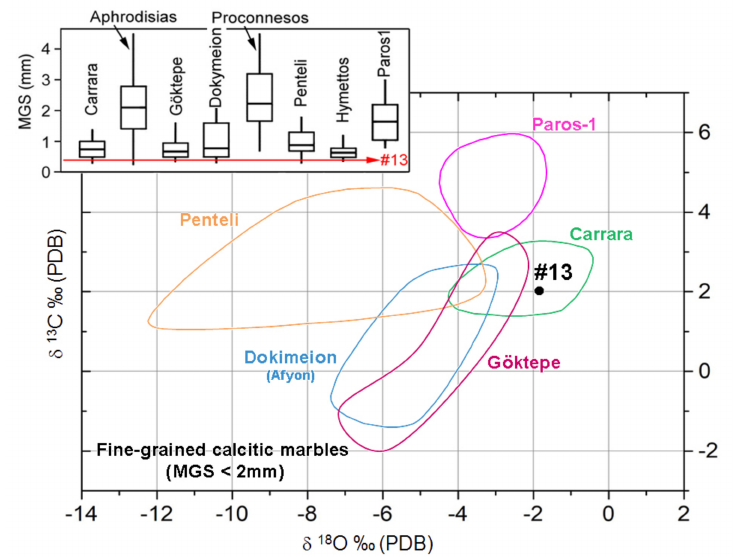
Figure 6. Isotopic signature of marble from tessera #13 plotted in a diagram depicting the isotopic fields for the main fine-grained classical marbles (after [48,49]). Top-left inset, MGS of tessera #13 plotted against several reference MGS box bars of calcitic marbles (after [50]).